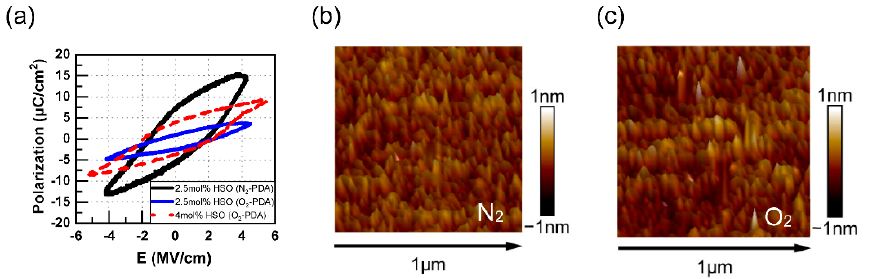
Figure 2. Summarized GIXRD patterns of ( a ) HSO films with different doping concentrations and ( b ) undoped HfO 2 films with different annealing atmospheres. ( c , d ) Extracted R O/T/C by fitting curves from ( a , b ). ( e ) PE curves of undoped, ~4% and ~6% HSO films with O 2 annealing. Only ~4% of doped Figure 3. ( a ) P-E curves of 2.5 mol% HSO films with N 2 - and O 2 -PDA, and 4 mol% HSO films with HfO 2 films show ferroelectricity. ( f ) The difference in current measured by PUND measurement O 2 -PDA. AFM results of 2.5 mol% HSO films which were annealed in ( b ) N 2 and ( c ) O 2 , respectively. demonstrates that undoped HfO 2 films with UHV annealing are ferroelectric.